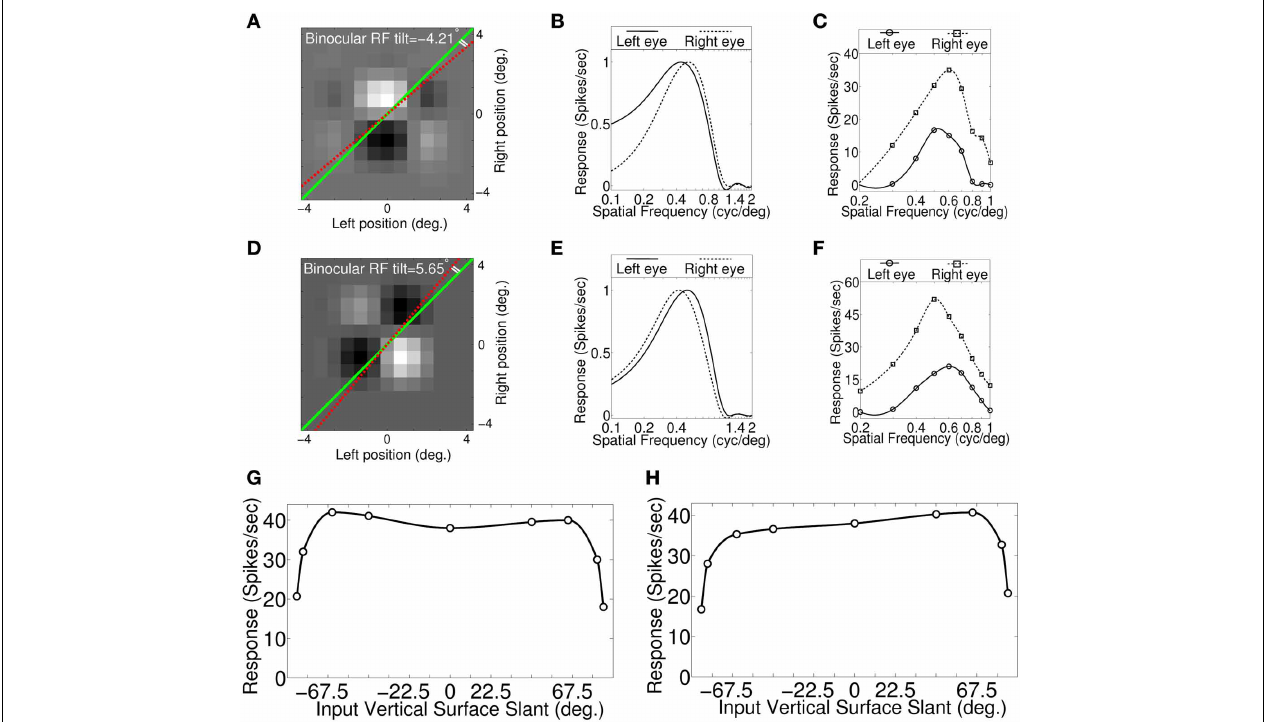
FIGURE 4 | Binocular RF, monocular spatial frequency tuning curves and Vertical surface slant tuning curves. (A) Binocular RF of a sample cell from our modeled cortex. The dotted red line and the green line indicate RF tilt angle and fronto-parallel line, respectively. This cell possesses significant RF tilt of − 4 . 21 ◦ . (B) Estimated monocular left and right eye spatial frequency tuning curves from binocular RF spectral profile. (C) Monocular left and right spatial frequency tuning curves obtained by stimulating model retina with